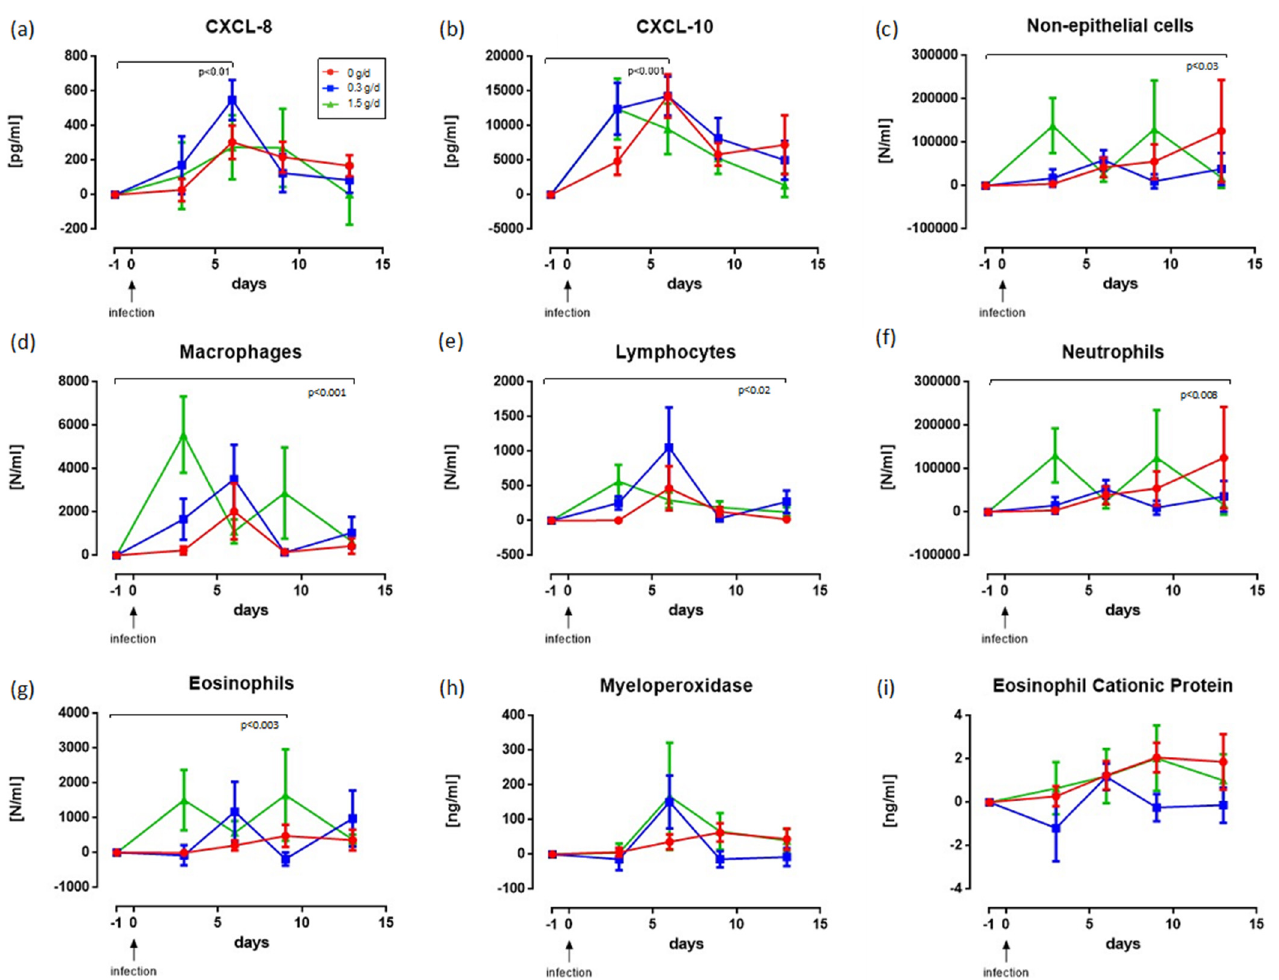
Figure 3. Time-dependent changes in CXCL-8 ( a ), CXCL-10 ( b ), cells in nasal lavage fluid ( c – g ) and granular proteins ( h , i ) expressed as change versus value just prior to infection (d-1). Each symbol represents the mean ± SEM. Significance was evaluated by step wise application of the change values of observations per person between d-1 and d13. The reported p -value in the various figures indicates the observed dose-dependent effect over the maximal time after infection for which significance was observed. ( a ) A dose of 0.3 g/day showed an earlier increase in values than doses of 0 and 1.5 g/day, and a higher peak than a dose of 0. ( b ) Higher doses led to earlier responses. ( c ) Higher doses led to higher numbers of cells in a time-dependent ( p < 0.03) parabolic fashion. ( d ) Higher doses led to higher numbers of cells in a time-dependent ( p < 0.001) parabolic fashion ( e ) A dose of 0.3 g/day yielded higher numbers of cells than doses of 0 and 1.5 in a time-dependent ( p < 0.002) parabolic fashion. ( f ) Higher doses led to higher numbers of cells in a time-dependent ( p < 0.08) parabolic fashion. ( g ) Higher doses led to higher numbers of cells in a time-dependent ( p < 0.003) parabolic fashion. ( h ) No significant difference in outcome was found between doses. ( i ) No significant difference in outcome was observed between doses. The cellular data (panels c – g ) above show relatively large standard errors of the mean due to some outliers affecting the mean profiles, especially on d9 and d13. Supplementary Figure S3 shows the same graph with the highest and lowest outliers removed; Supplementary Figure S2 shows the absolute values including the values at baseline